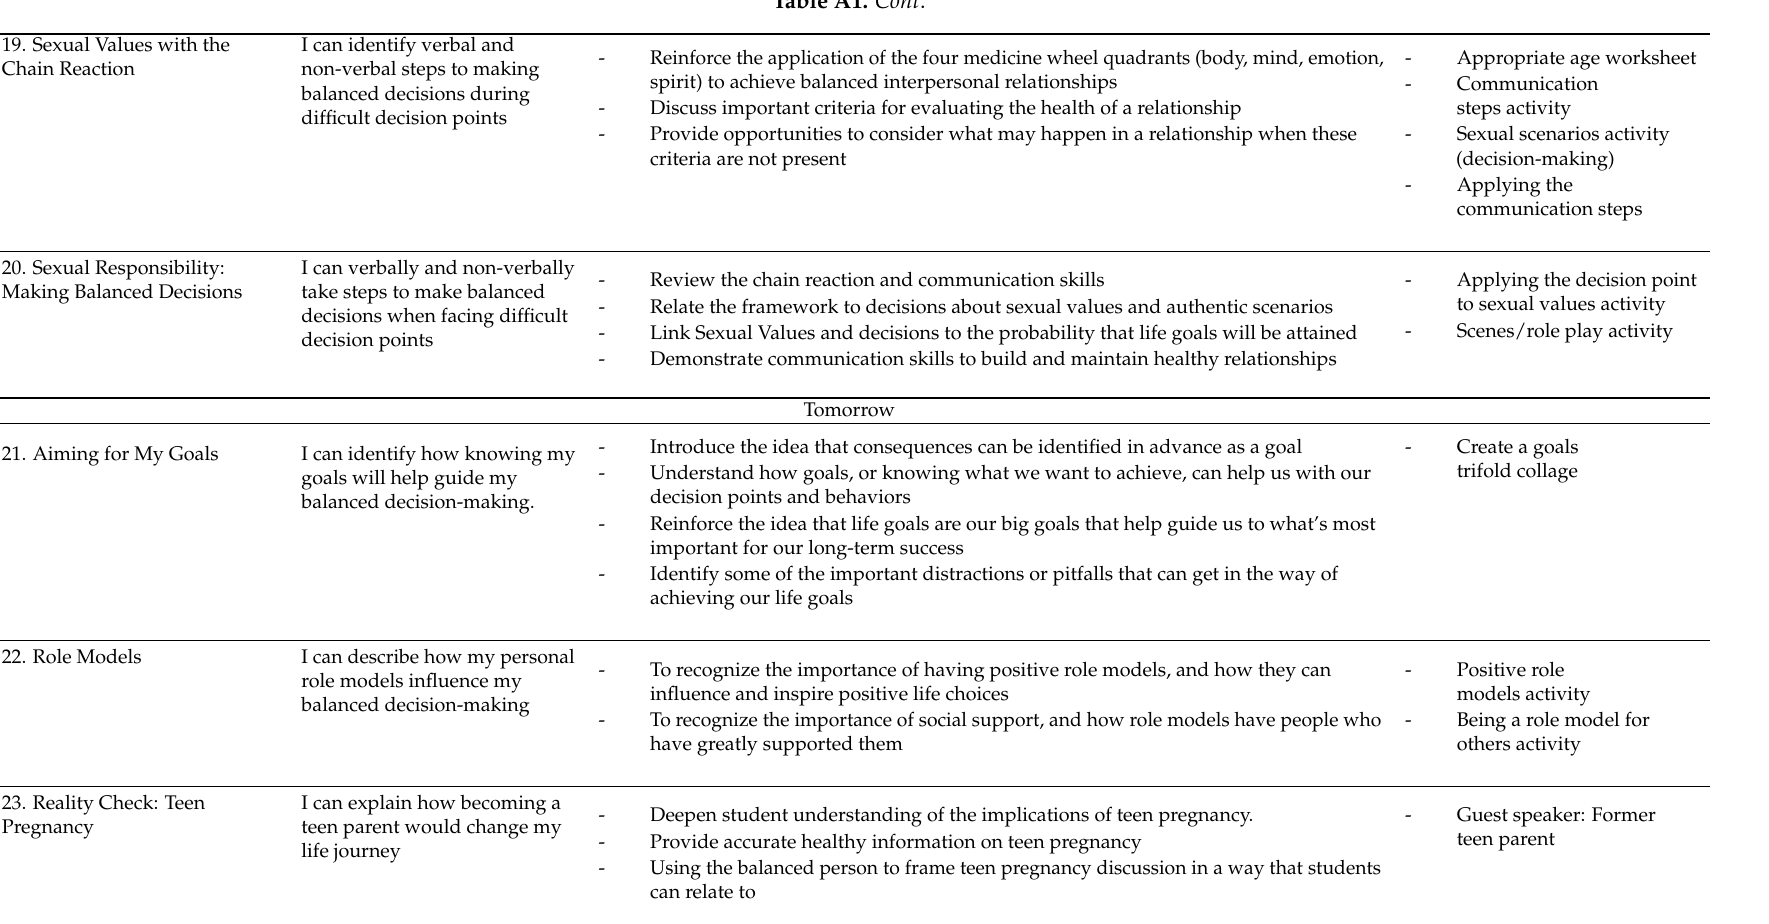
- Appropriate age worksheet - Communication steps activity - Sexual scenarios activity (decision-making) - Applying the communication steps